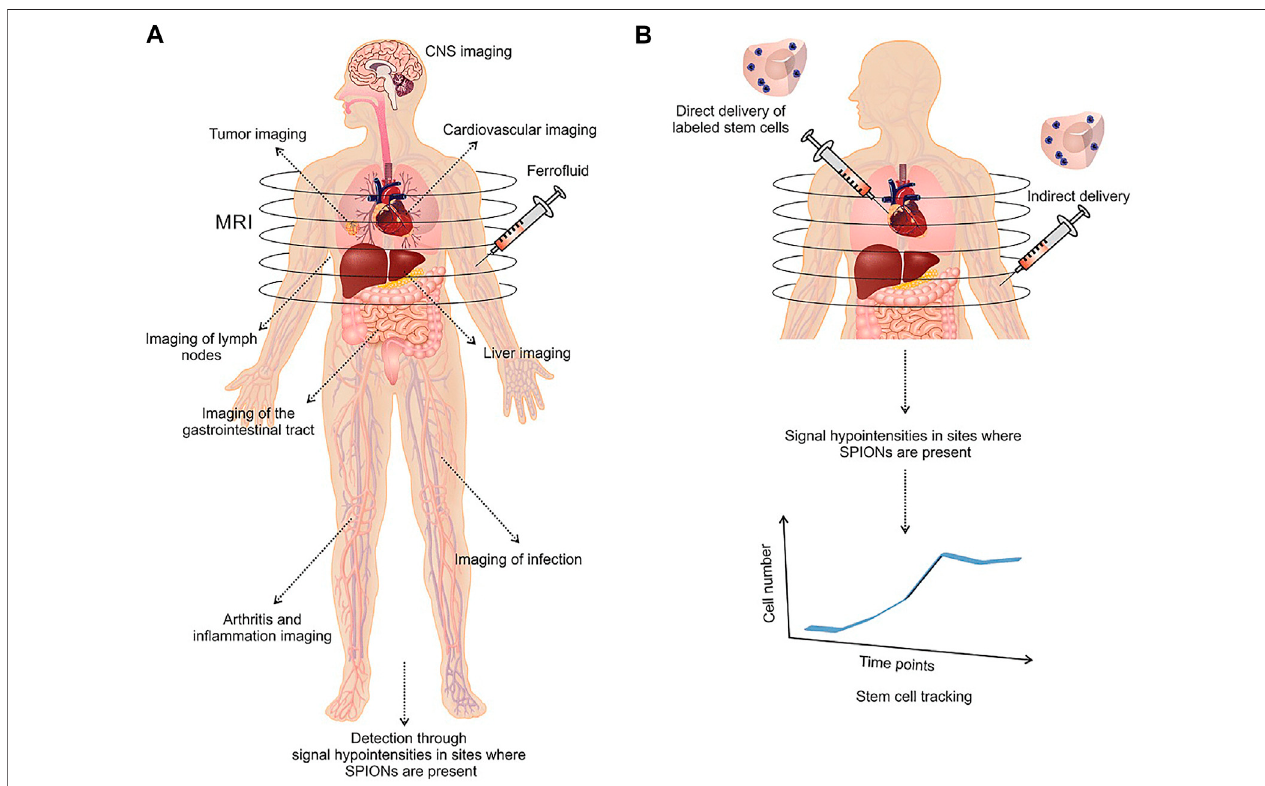
FIGURE 2 | Medical applications of SPION-based MRI in liver, cardiovascular, in fl ammation, gastrointestinal tract, CNS, and tumor imaging (A) . Application of SPION-labeled stem cells as a monitoring regenerative therapy in tracking of stem cells after transplantation (B) . Reproduced with permission (Shari fi et al., 2015) Copyright 2015,